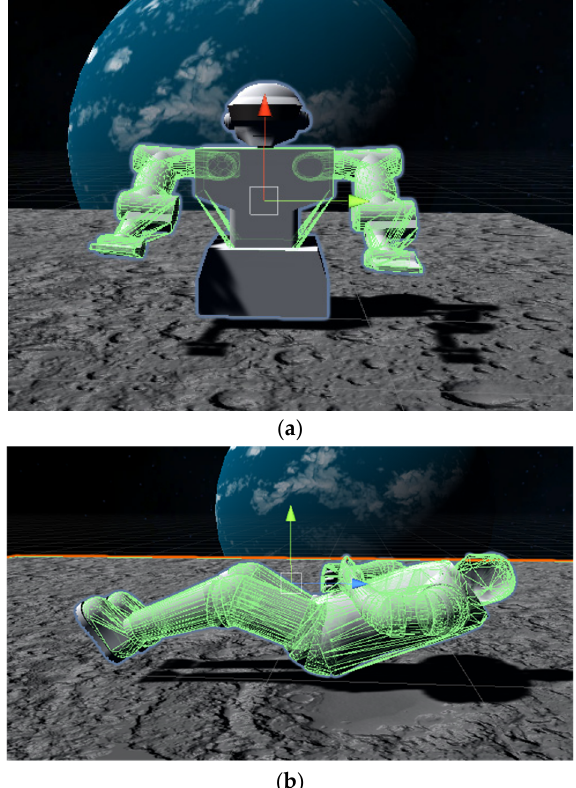
Figure 2. Obstacle avoidance model. ( a , b ) Lunar robot collision detection configuration.